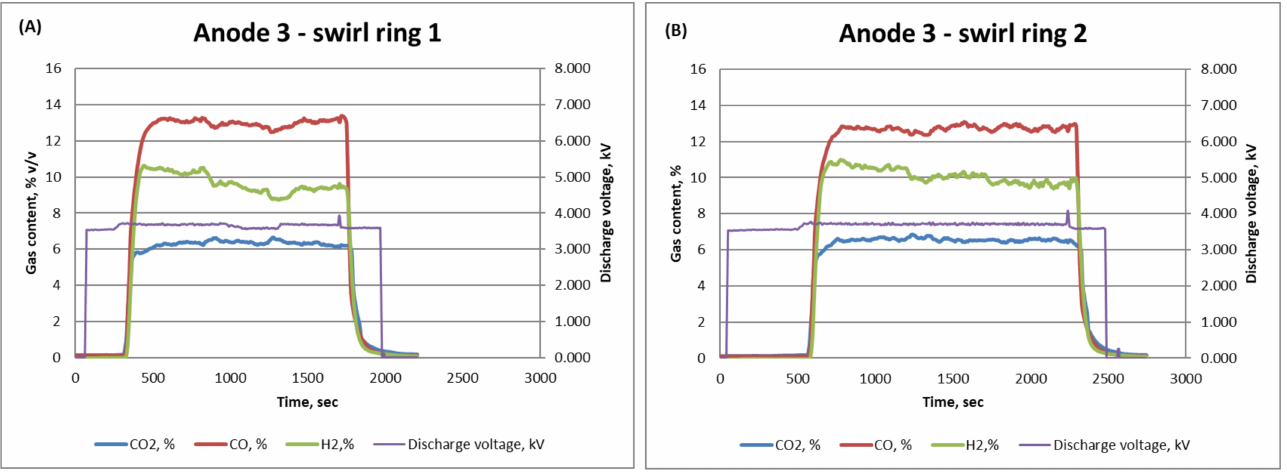
Figure 11. Comparison between Rings 1 ( A ) and 2 ( B ) with Anode 3.